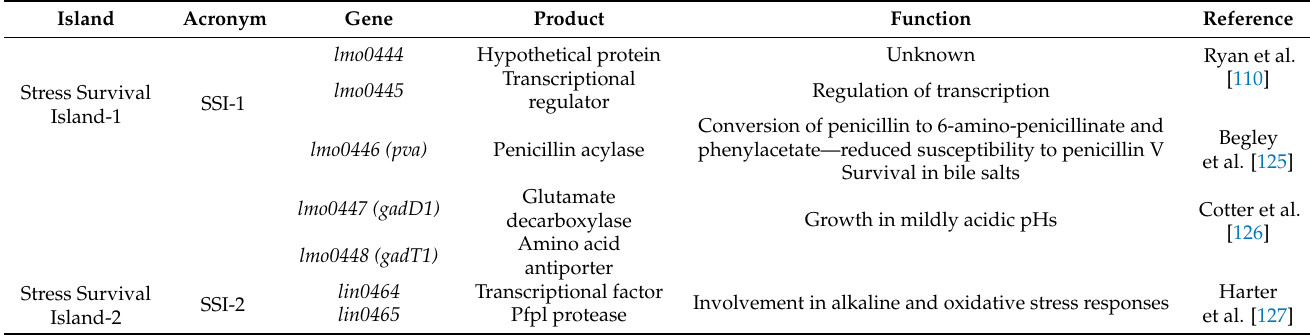
Figure 2. Scheme of the genetic organization of genes mapping to stress survival islands. Created using Easyfig [33]. (see also Table 2). Table 3. Stress survival islands detected in Listeria monocytogenes.